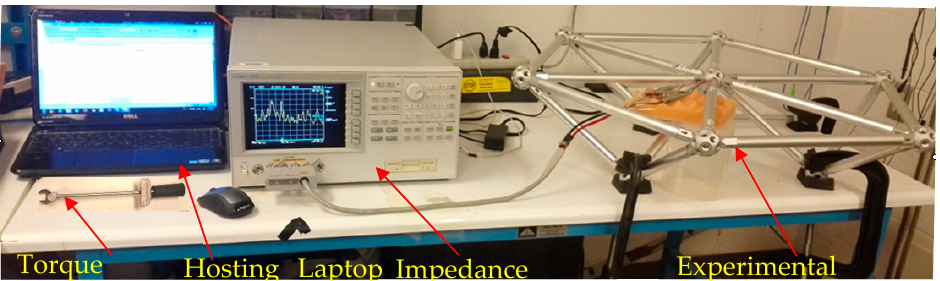
Figure 7. Experimental setup.